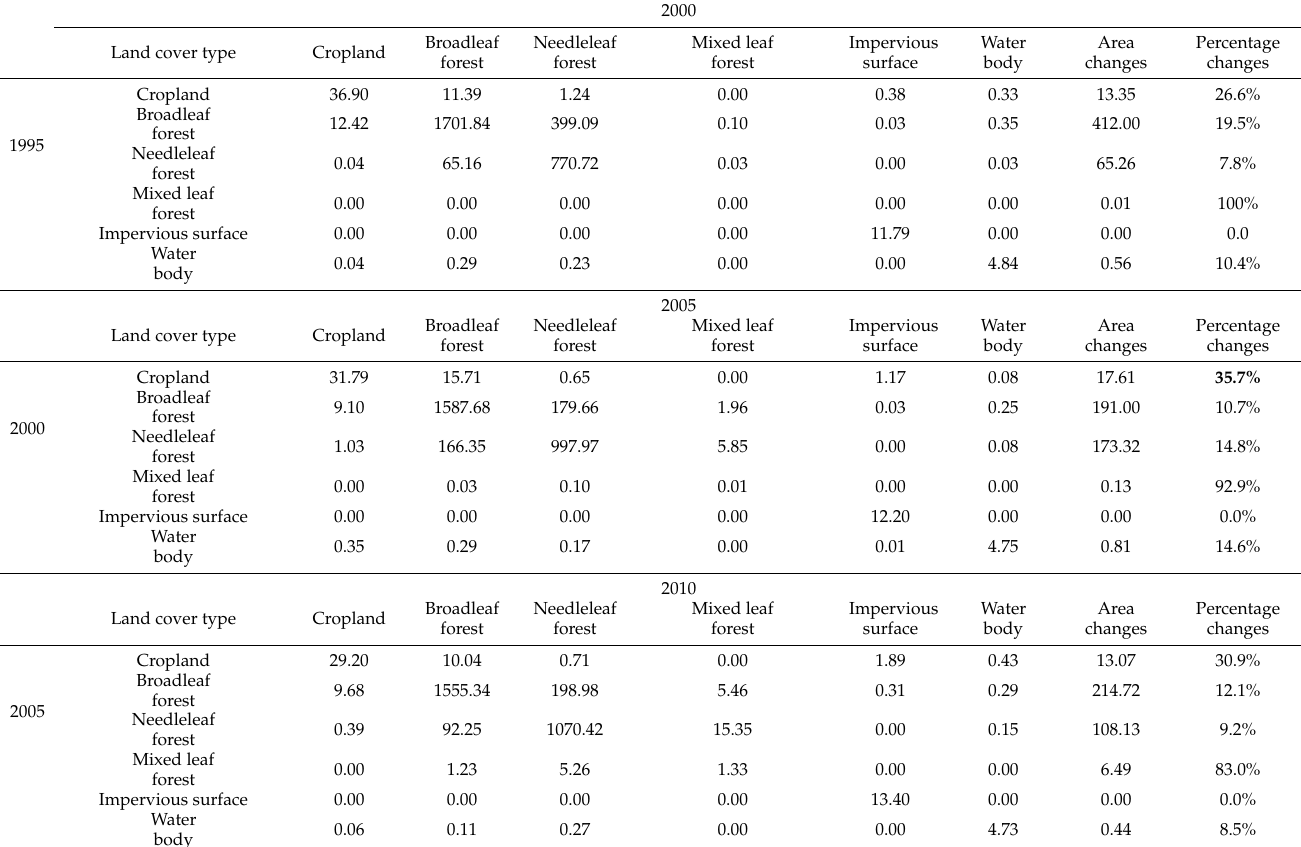
Table A1. Transition Matrices of Changbai Mountain from 1995 to 2020 (Unit: km 2